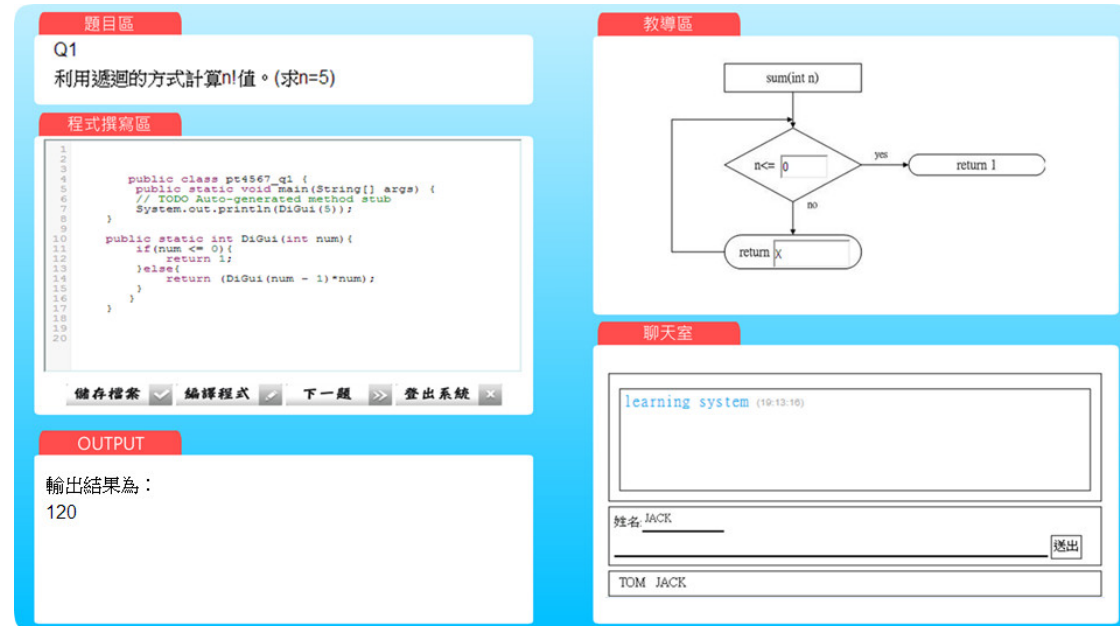
Figure 3. System frame−Experimental group B (tutee).